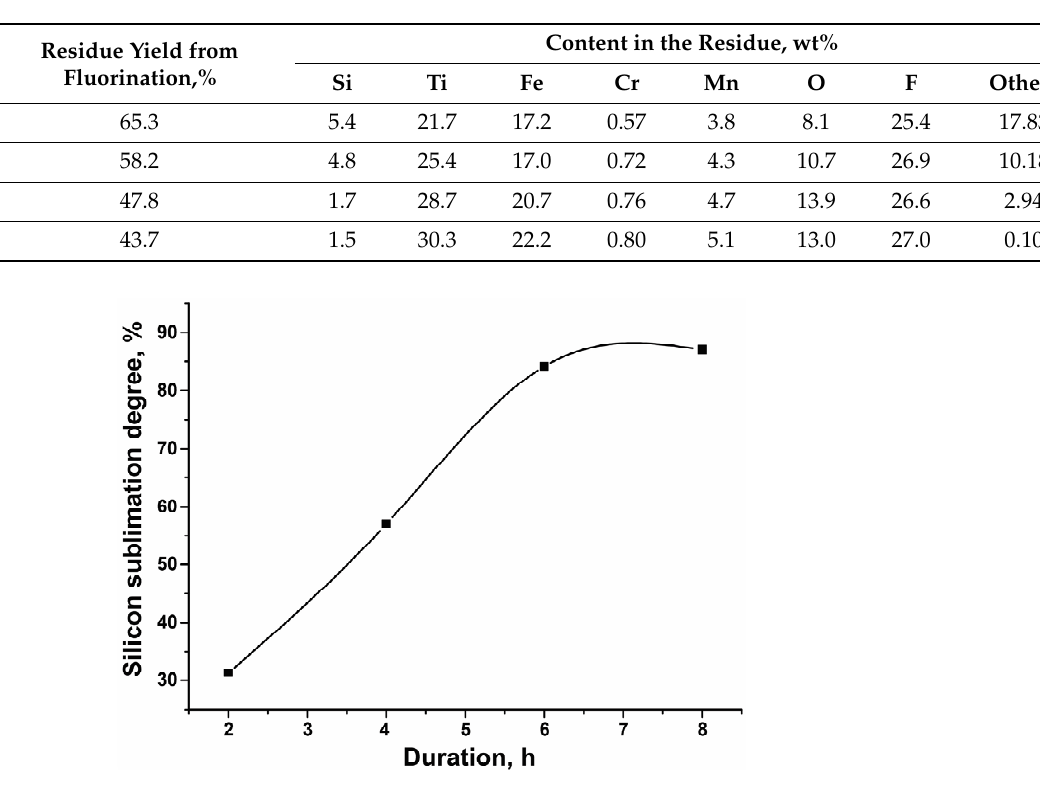
Table 3. Results of fluorination of electrosmelting dust of ilmenite concentrate. Influence of the pro ‐ cess duration.